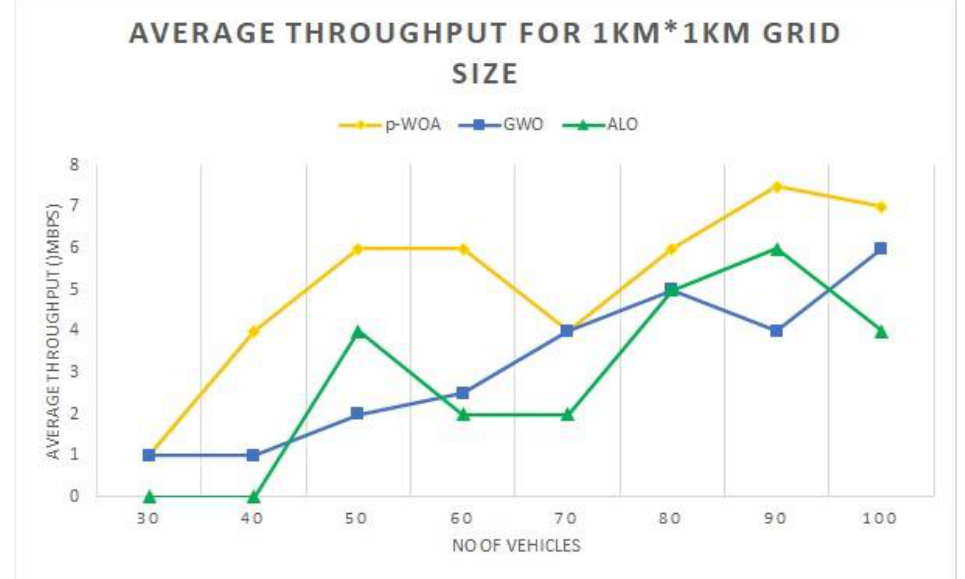
Figure 9. Average Throughput for 30 – 100 Nodes by taking 1 km * × 1 km Grid Size .